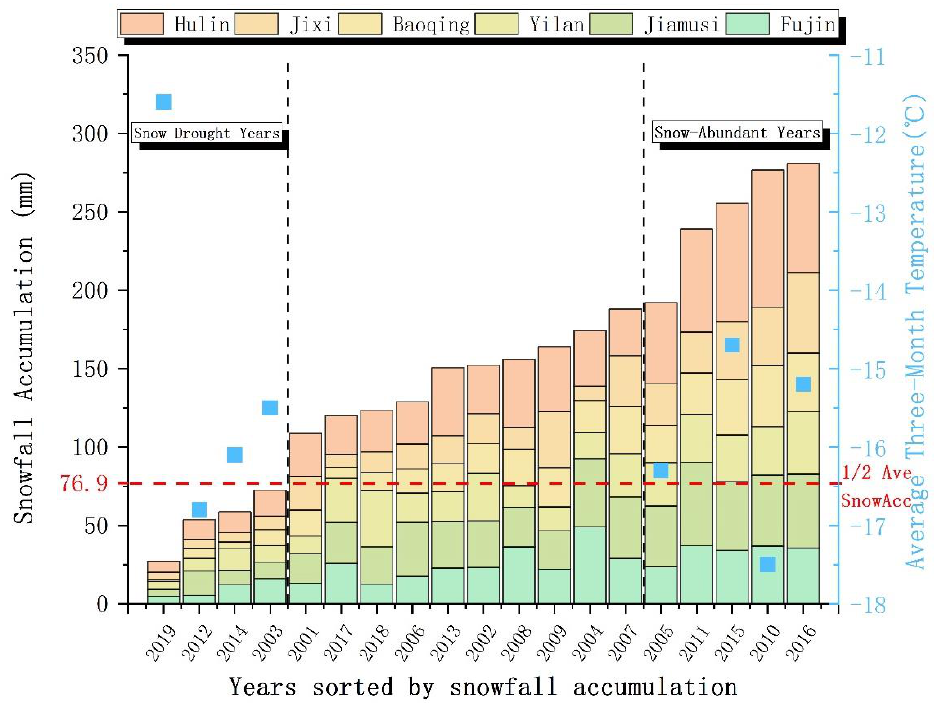
Figure 3. Applied meteorology and detection of snow drought in this study.